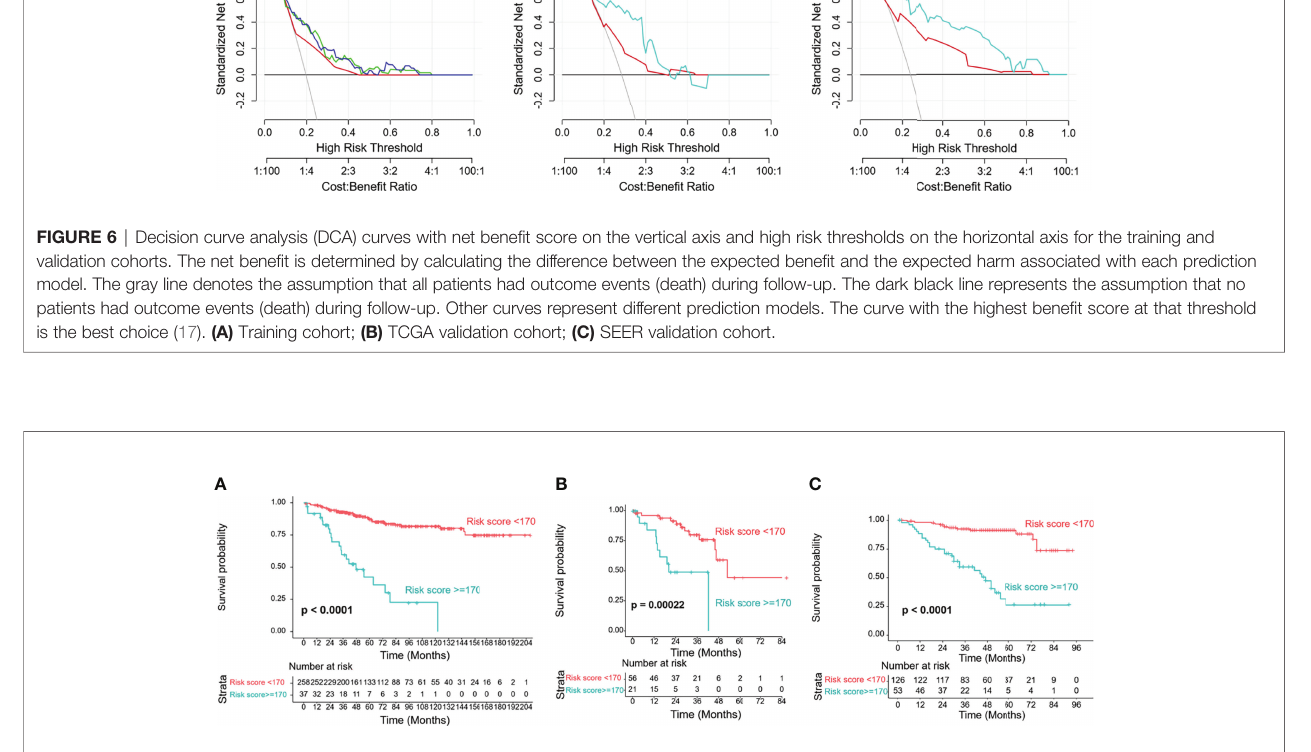
FIGURE 7 | Risk group strati fi cation of the training and validation cohorts by the cutoff value of 170. (A) Training cohort; (B) TCGA validation cohort; (C) SEER validation cohort.